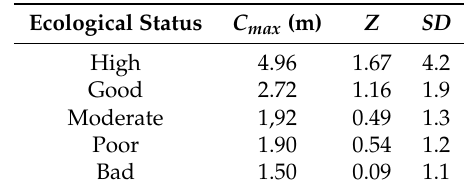
Table 1. Mean values of the indicators used in the Ecological State Macrophyte Index ( ESMI ) approach ( Z —colonization index, C max —maximum vegetation depth) and mean SD (Secchi disc) of 88 lakes in northern Poland and the Ł˛eczy´nsko-Włodawskie Lake District (after Ciecierska et al. [3]).